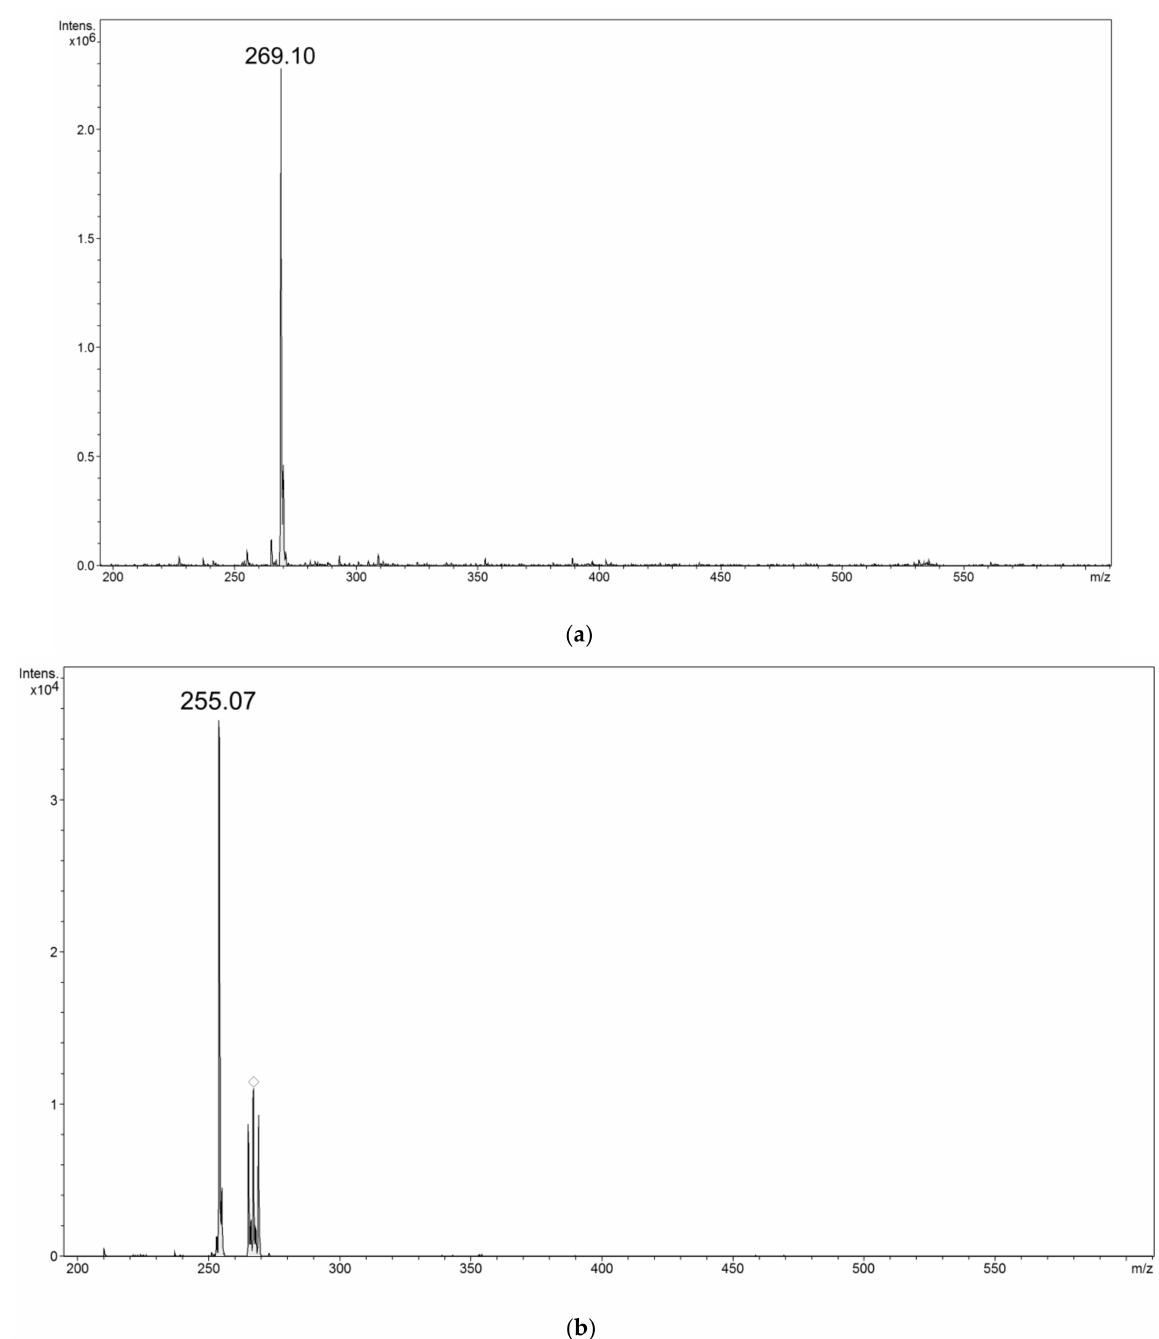
Figure 8. The spectra of DH-2-MC recorded in ( a ) FAPA-MS and ( b ) FAPA-MS 2 modes. The chalcone’s spectrum after applying the low collision energy to the molecular signal m / z 269 shows the main fragmentation signal at m / z 255, which is related to the chalcone’s fragmentation ion after the loss of -CH 3 group of methoxy